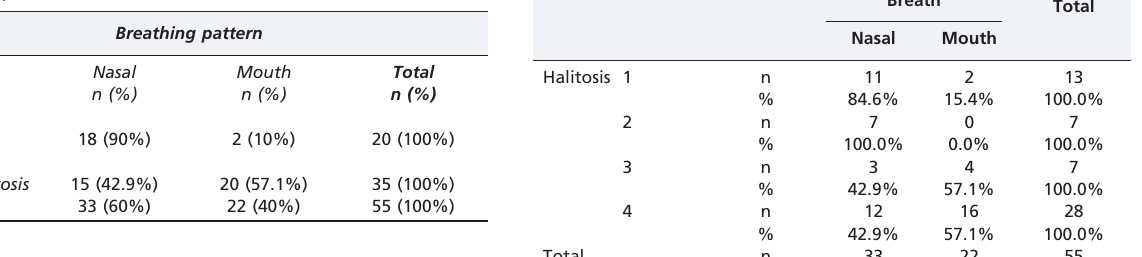
Table 3 - Analysis of the association between halitosis and breathing pattern.